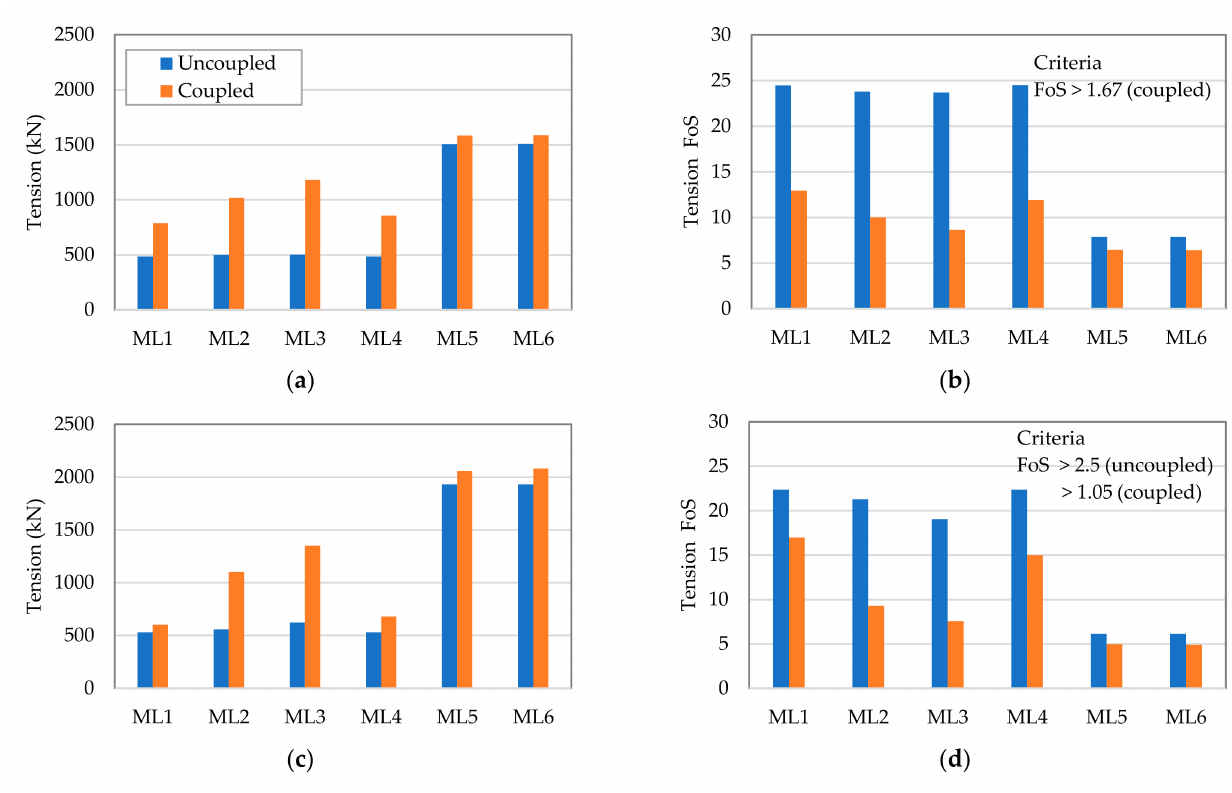
Figure 13. Buoy mooring line tensions and FoSs for 0 deg. heading: ( a ) tensions for 50 y; ( b ) tension FoSs for 50 y; ( c ) tensions for 100 y; ( d ) tension FoSs for 100